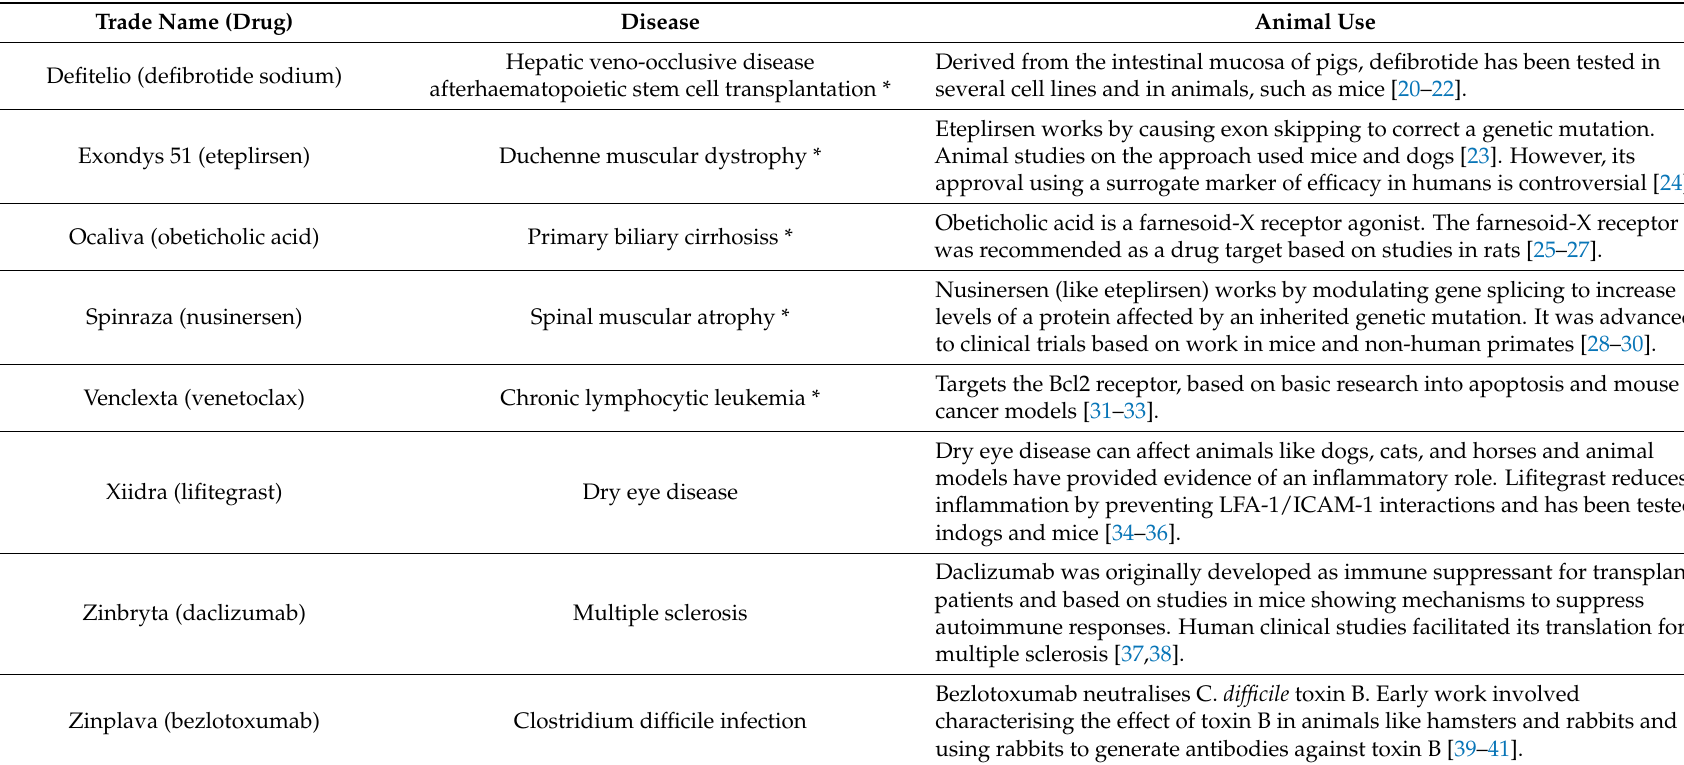
Table 1. Basic and preclinical animal research and first-in-class drugs approved by the United States Food and Drug Administration in